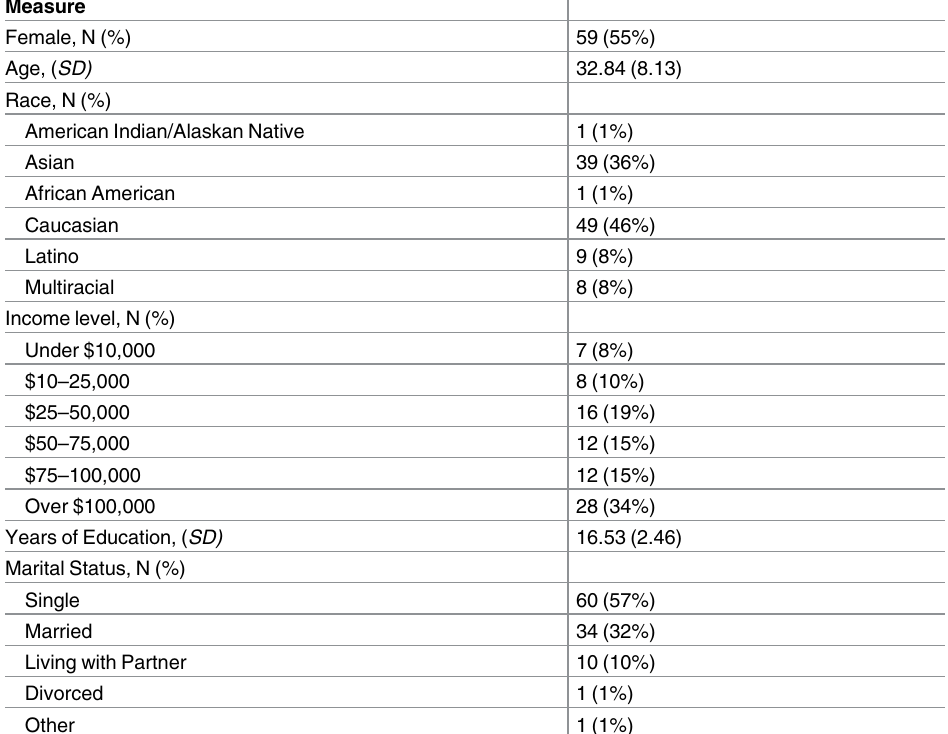
Table 1. Participant demographics (N =